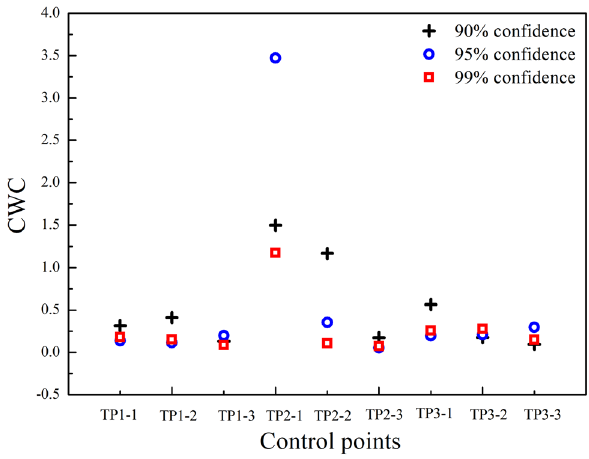
Figure 9. CWC values of PIs at different confidence